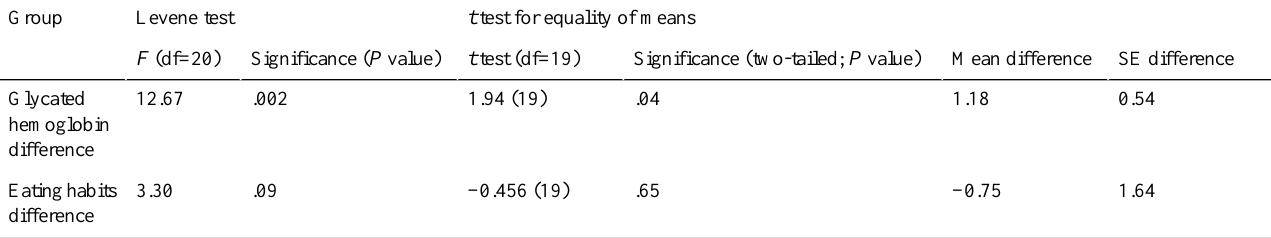
Table 6. Between-group differences for both glycated hemoglobin and eating